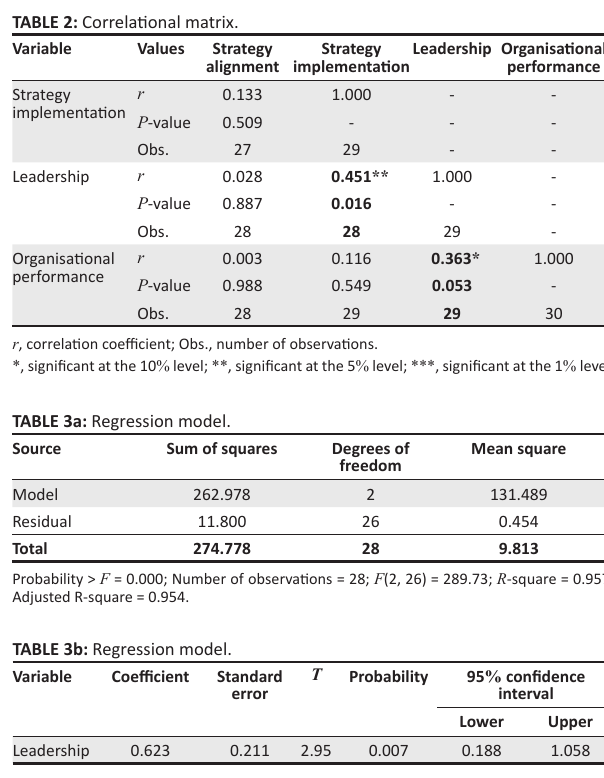
TABLE 2: Correlational matrix. Variable Values Strategy Strategy implementationLeadership Organisational alignment r Strategy implementation